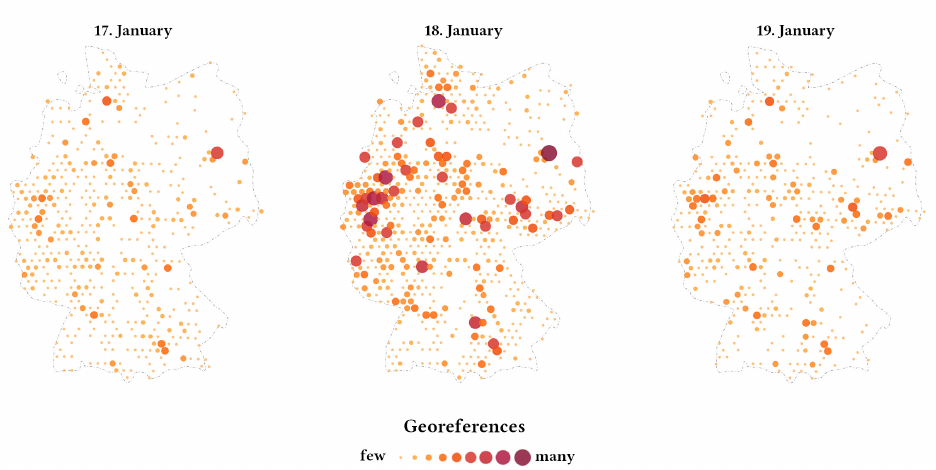
Figure 8. Spatially aggregated frequencies of georeferences according to hexagons 20 km-wide derived from toponyms of storm-related tweets between 17 and 19 January 2018. Small yellow dots indicate a low societal response, whereas large purple dots represent a strong societal echo in the considered zone.